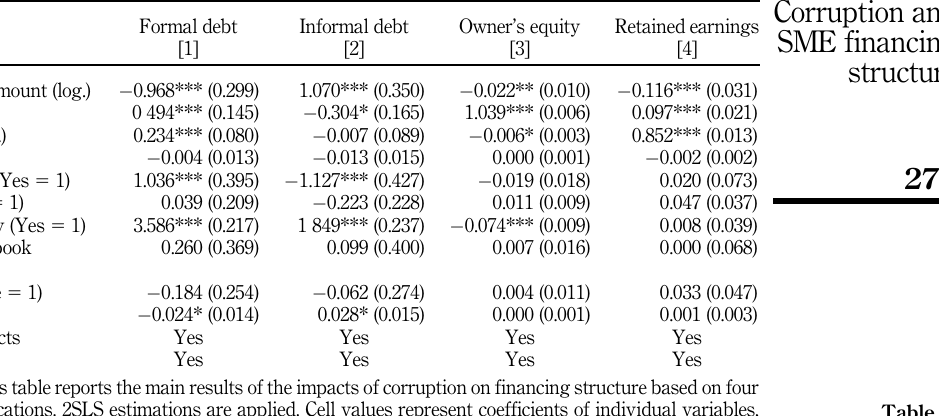
Table 5. Impacts of